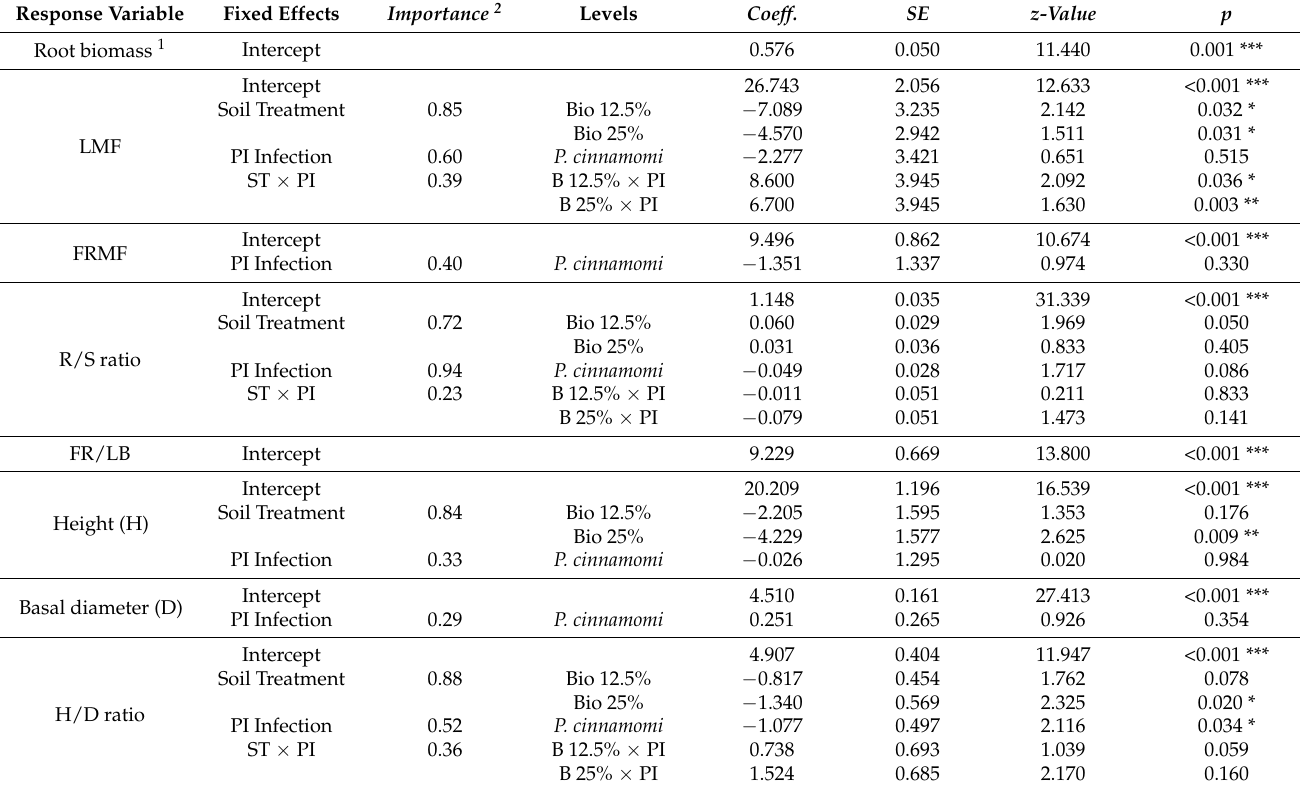
Table 2. Summary of the top linear mixed models ( ∆ AIC < 2) fitted to analyse main and interaction effects of factors soil treatment (ST) and P. cinnamomi infection (PI) on morphological variables (II and III models in Table 1). Asterisks indicate statistical significance ( p < 0.05 *, p < 0.01 **, p < 0.001 ***).